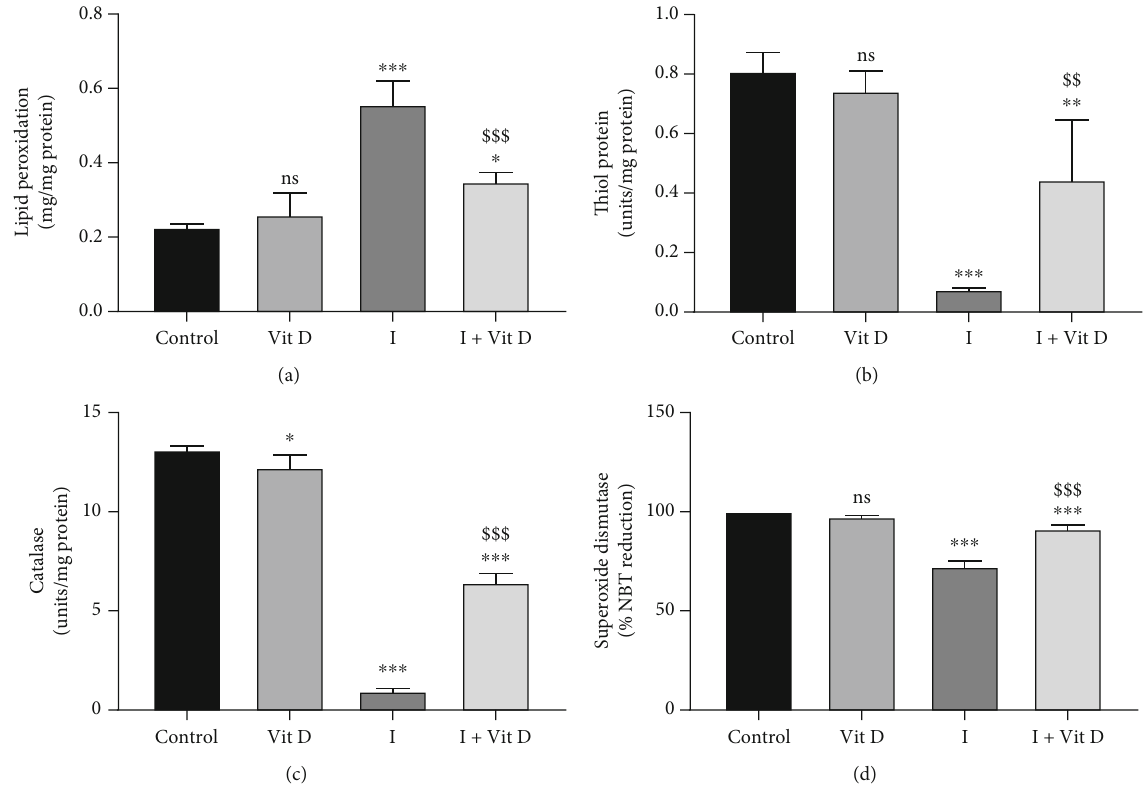
Figure 4: Levels of (a) lipid peroxidation, (b) thiol protein, (c) catalase, and (d) superoxide dismutase activity in Vero cells treated with iohexol at a concentration of 100mg iodine/mL or pretreated with 1 μ M vitamin D3. Results are represented as mean ± SD . One-way ANOVA and Tukey posttest ( n = 4 ) were used to analyse the results. ns: not signi fi cant; ∗ p < 0 : 05 , ∗∗ p < 0 : 01 , and ∗∗∗ p < 0 : 001 (2-tailed) versus control; $ p < 0 : 05 , $$ p < 0 : 01 , and $$$ p < 0 : 001 (2-tailed) iohexol (I) versus iohexol+vitamin D (I+Vit D) groups.